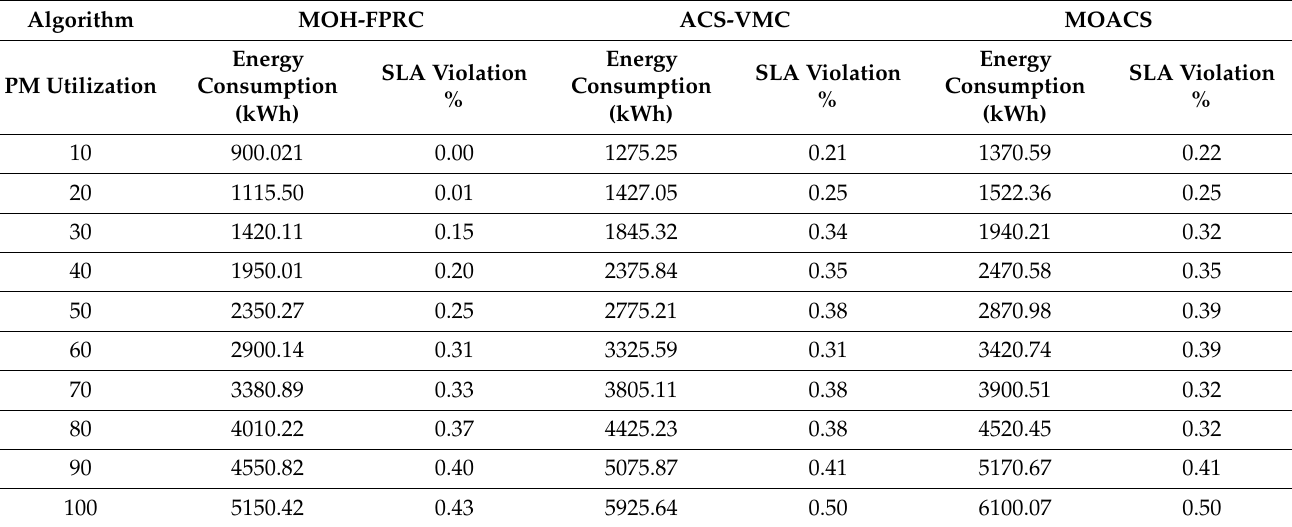
Table 3. Average energy consumption and SLA violation with different PM